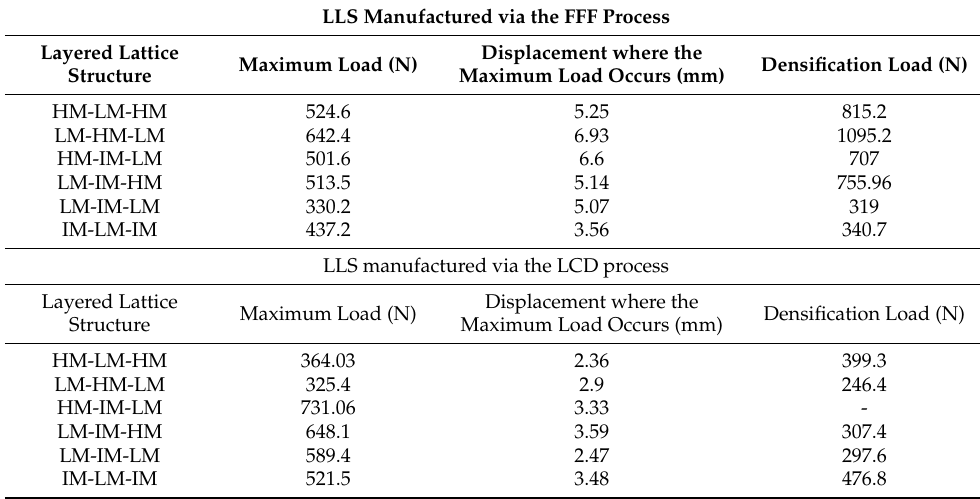
Table 4. Data obtained from compression tests for LLS